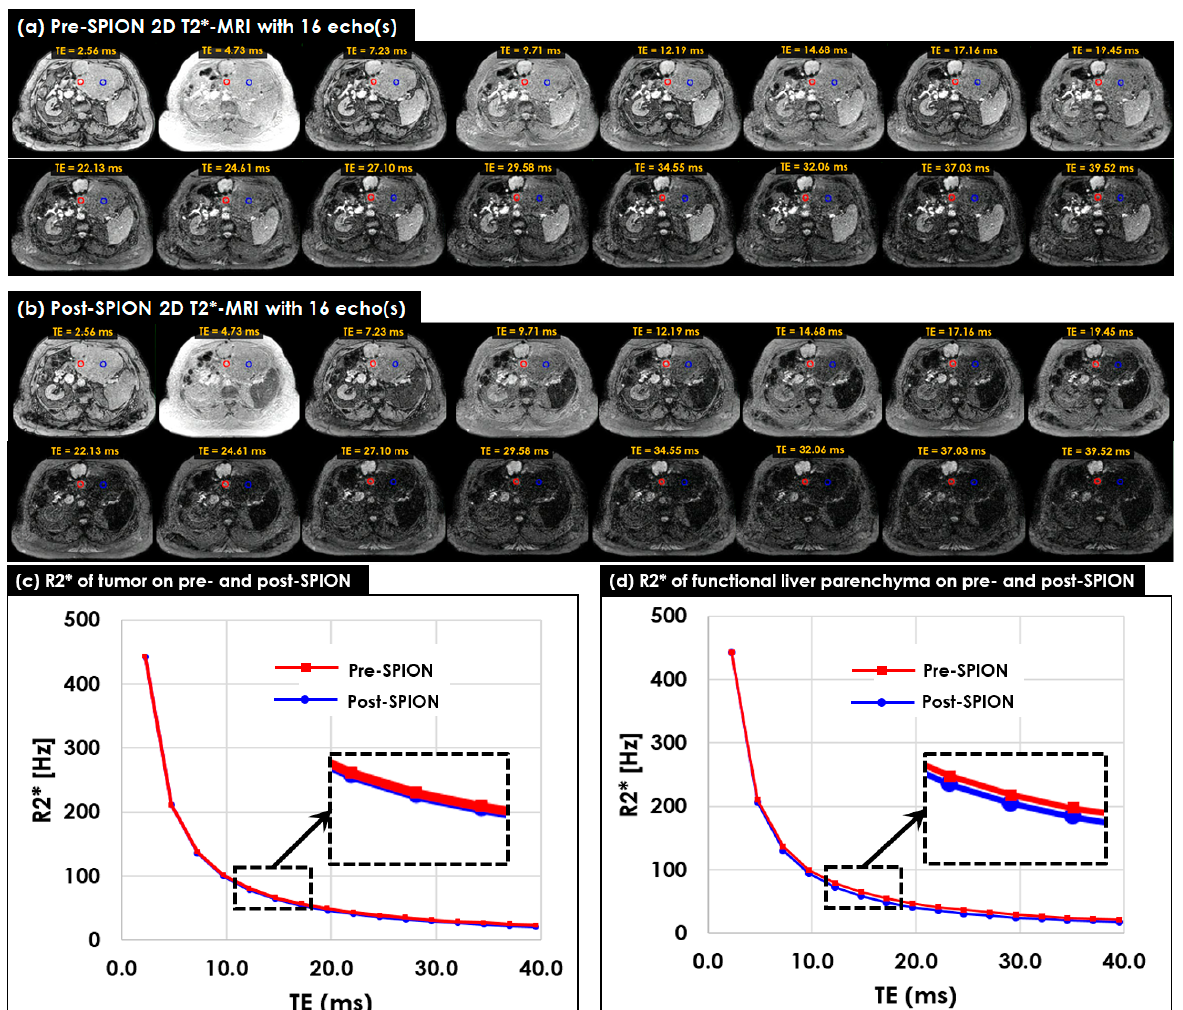
Figure 3. Pre- and post-SPION multi-echo 2D T2*-MRI and R2*-MRI in P09. ( a ) Pre- and ( b ) post- SPION 2D T2*-MRI with 16 echoes acquired at every 2.3 ms before and after 72 h after the SPION injection. Two circles with a 2 cm diameter were placed on the regions of tumor (red circle) and FLP (blue circle) to measure the changes in terms of R2* within the two circles at every echo on ( c ) pre- and ( d ) post-SPION R2*-MRI. An average of the R2* in the regions of tumor and FLP was used to depict a varying R2* [Hz] across 16 echoes. The R2* in the FLP region, compared to the R2* in the tumor region, noticeably changed (Student’s t -test p -value < 0.001), as shown in the dotted rectangles in ( c , d ) at around TE = 13.8 ms.